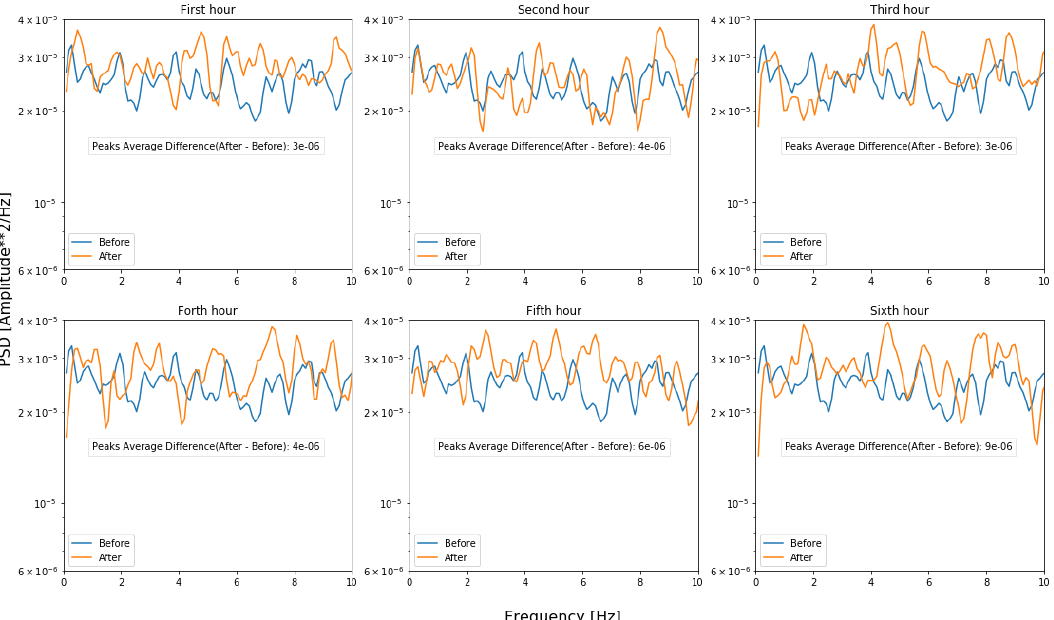
Figure 13. PSD Frequency domain plot for data collected from outside sensor before and after inserting Red Palm Weevils through hours.